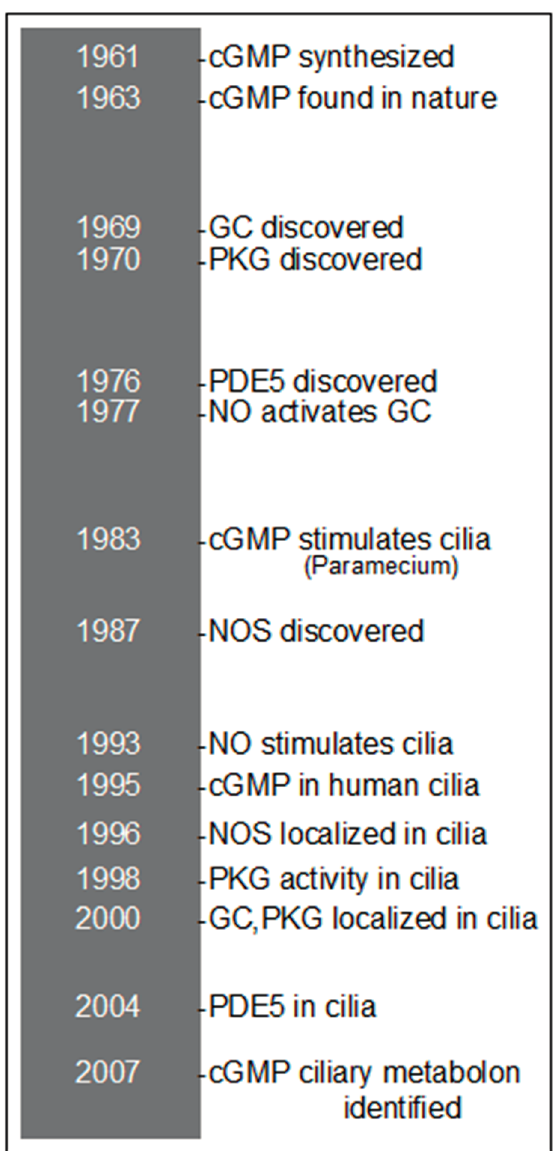
Figure 1. 50-year timeline of cGMP and cilia